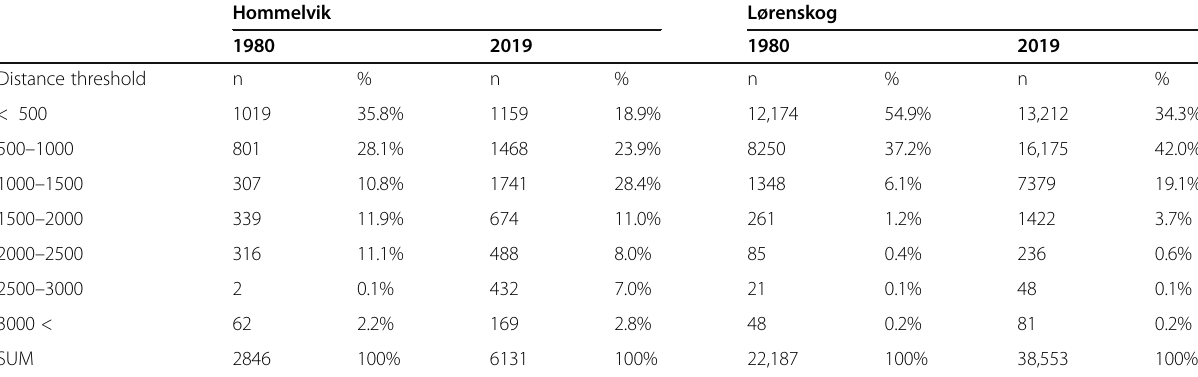
Table 2 Numbers and percentage of population within different walking distances in 1980 and 2019 Hommelvik